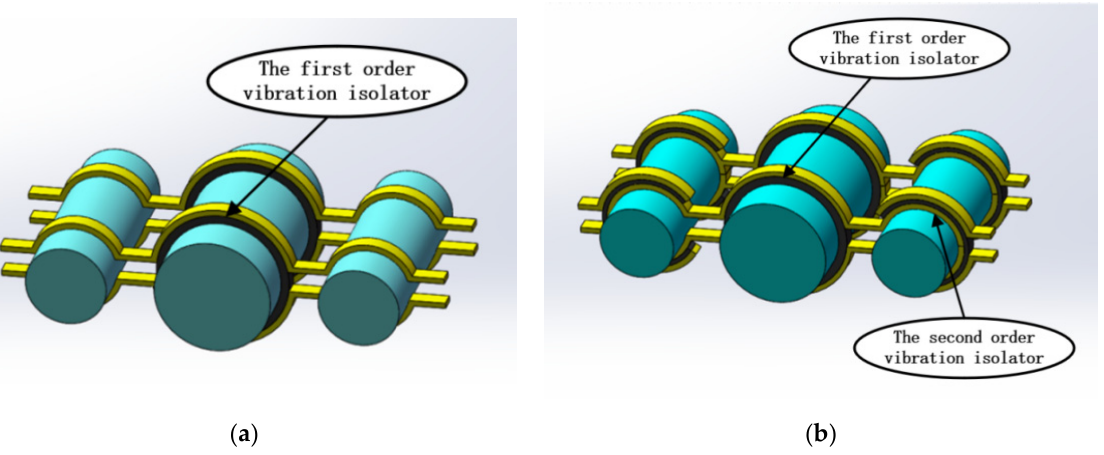
Figure 3. Structure of ( a ) the single-stage vibration isolator of the power system in the AUG, and ( b ) the two-stage vibration isolator of the power system in the AUG. ( b ) the two-stage vibration isolator of the power system in the